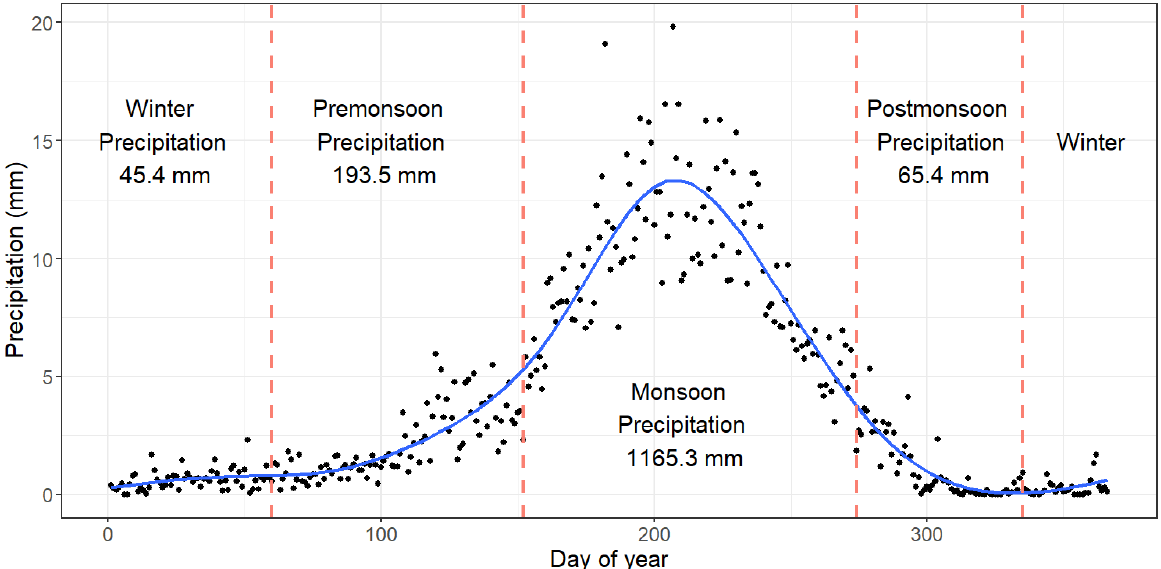
Figure 3. Mean daily (black dots) and smoothed average (blue line) precipitation in the study area over the years, averaged over 68 years (1948 to 2015).